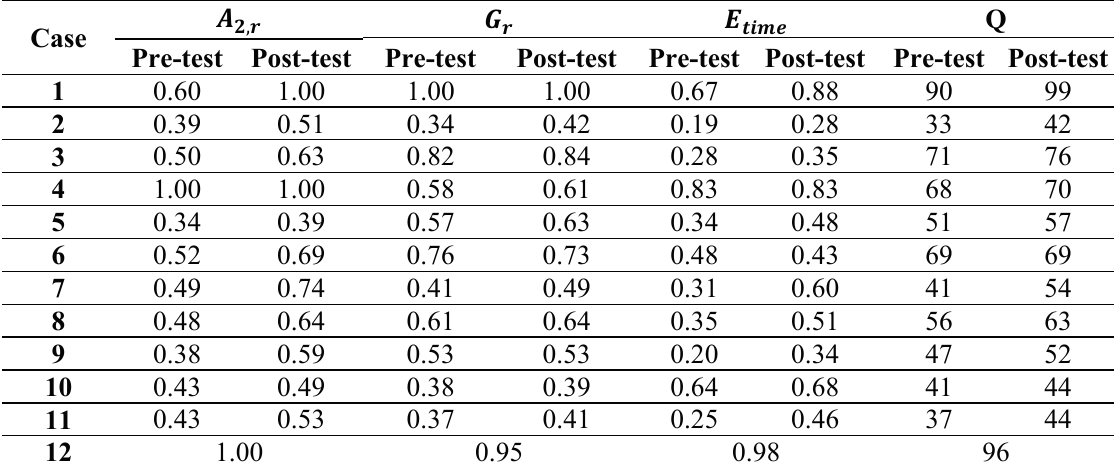
Table 4. Results of objective evaluation score for stroke patients and a healthy adult.